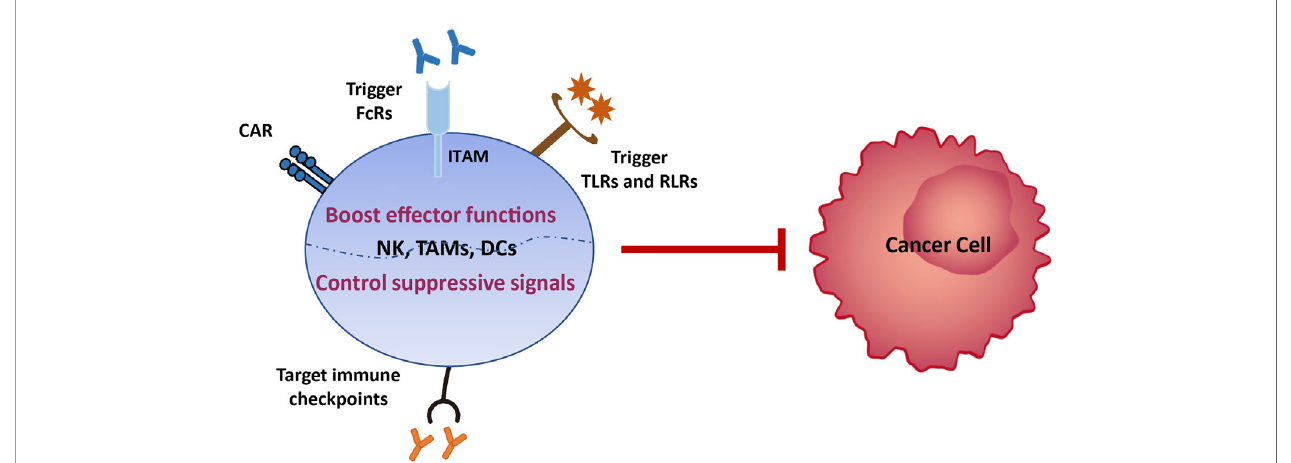
FIGURE 4 | Immunotherapy strategies based on innate immune cells. Various tumor treatment regimens can be implemented by boosting the effector functions of innate immune cells, including generating engineered CAR NK cells with high anti-tumor activity and CAR macrophages which can be polarized towards an anti- tumor M1 phenotype, developing anti-tumor antibodies that can bind to activating FcRs expressed on innate immune cells lacking antigen receptors, and enabling them to act speci fi cally on EC cells, and targeting toll-like receptors (TLRs) and RIG-I-like receptors (RLRs), to generate a ‘ pathogen-induced-like ’ innate immune responses at the tumor site, since the innate immune system can sense the nucleic acids of growing tumors using the pathogen and damage receptors involved in infection detection. Another immunotherapy strategy is to control immunosuppression signals on innate immune cells via development of broad-spectrum immune checkpoint inhibitors targeting NK cells (i.e., LAG3, TIM3, and PD-1, which we review here, and NKG2A, CTLA4, TIGIT, and CD96 which require further investigation) and/or myeloid cells (i.e., SIRP a